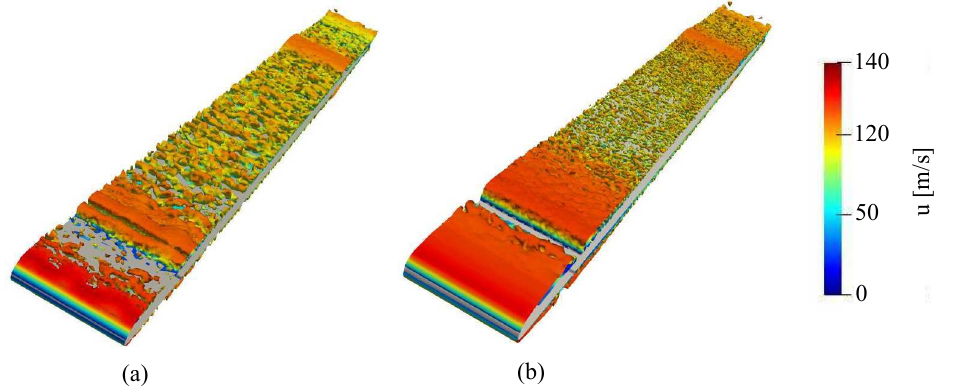
Figure 4. Iso-surfaces of Q-criterion ( QC 2 / U 2 = 1000), colored by the velocity magnitude, for ( a ) GeomX10H1-P25W30 simulation and ( b ) GeomX10H4-P25W30 simulation.